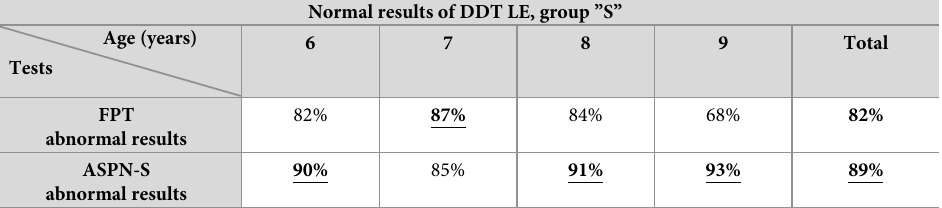
Table 8. Percentage of abnormal FPT and ASPN-S test results with a normal result of the DDT LE test and an abnormal result of DDT RE, group”S”. Normal results of DDT LE, group